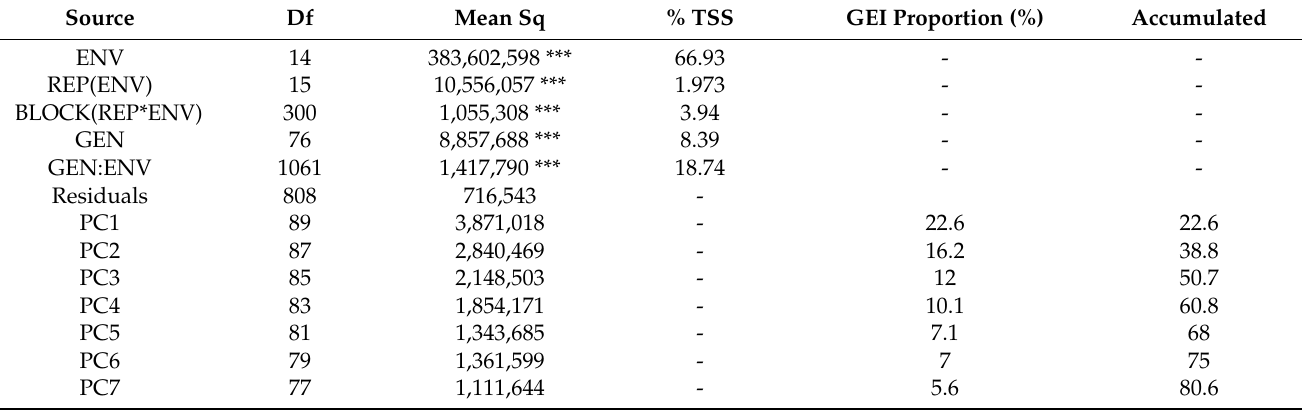
Table 4. Analysis of variance and significant interaction components from the AMMI model of durum wheat lines derived from interspecific crosses and checks grown in contrasted environments in Morocco and Sudan.